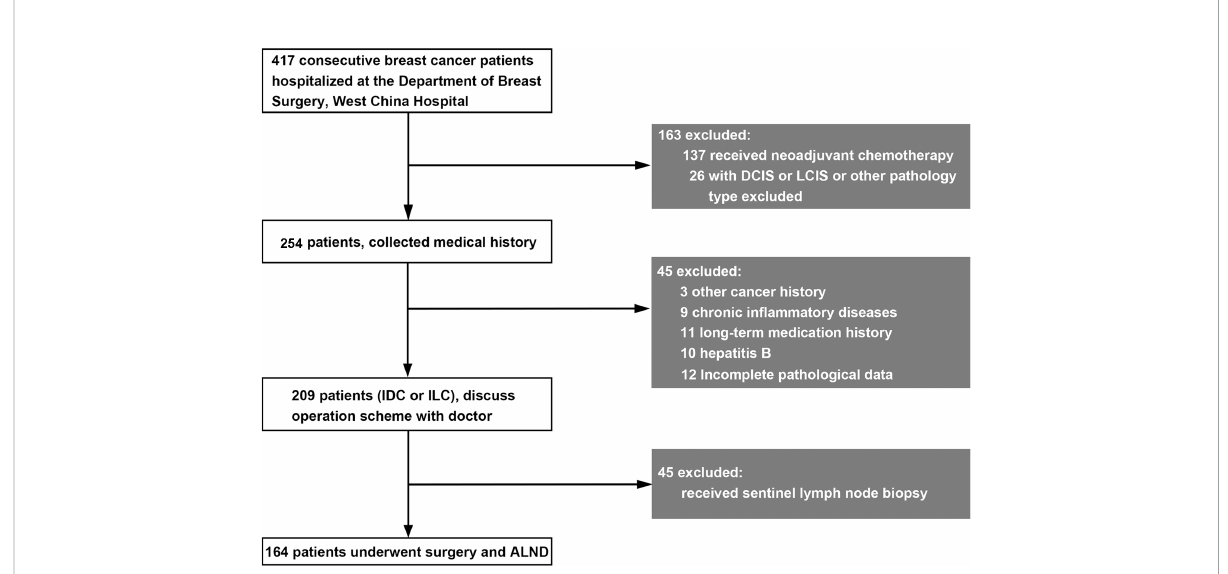
FIGURE 1 Inclusion and exclusion criteria for breast cancer patients in this study. DCIS, ductal carcinoma in situ; LCIS, lobular carcinoma in situ; IDC, invasive ductal carcinoma; ILC, invasive lobular